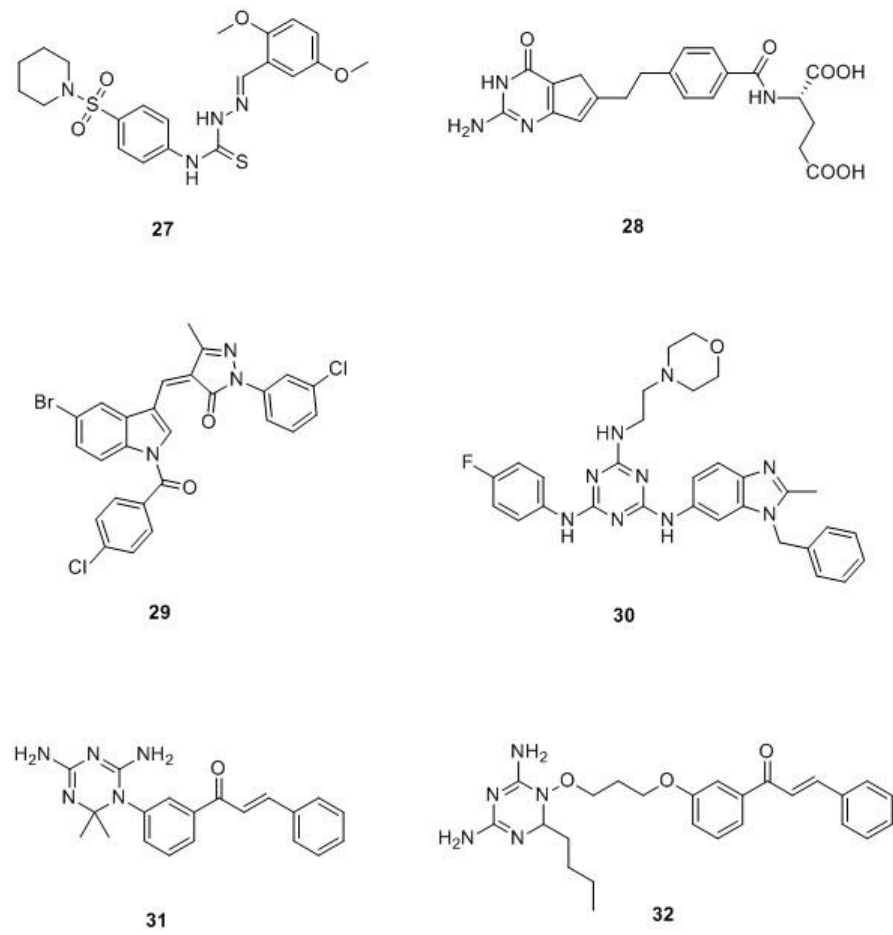
Figure 12. Chemical structures of dual inhibitors.